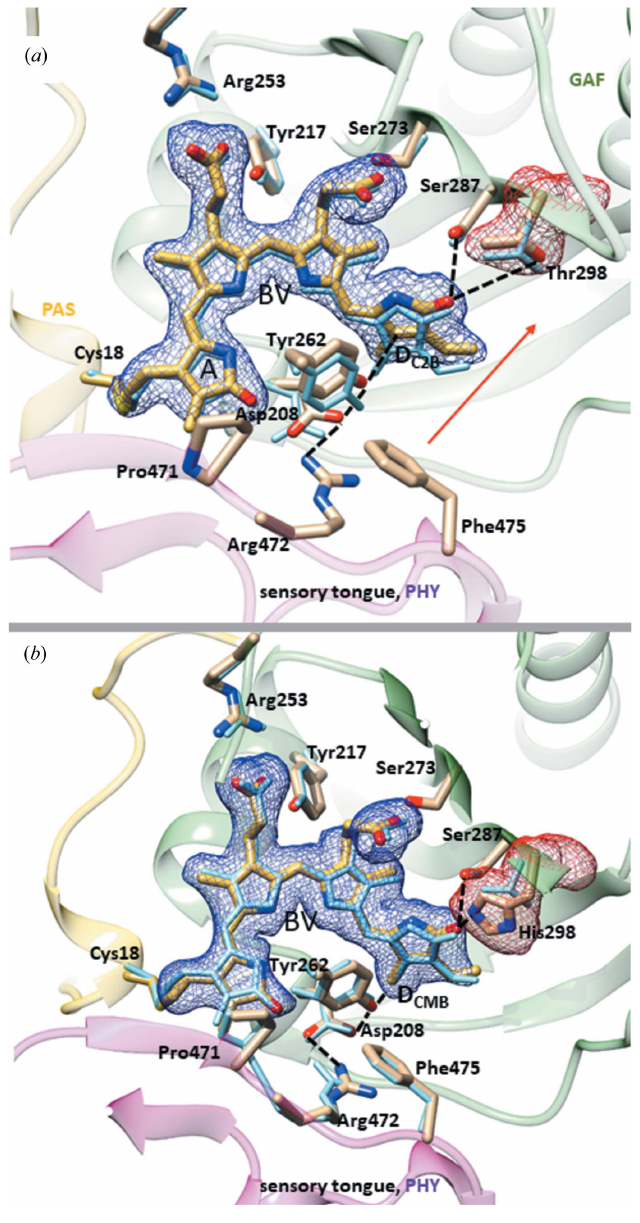
Figure 6 Structural changes in SaBphP1 near the BV chromophore. Important residues are marked. Important salt and hydrogen bonds are shown by dashed lines. ( a ) Effect of adding the PHY domain. Blue atomic structure, CBD-wt; yellow atomic structure, PCM-wt. The electron density (simulated annealing OMIT mF o (cid:5) DF c , dark blue, contour level: 2 (cid:7) ) is shown for the chromophore and the Thr289 (red). The red arrow indicates the overall trend of the changes. ( b ) Effect of the T289H mutation. Blue atomic structure: PCM-wt, yellow atomic structure: PCM- T289H. The electron density (simulated annealing mF o (cid:5) DF c , light blue, contour level: 2 (cid:7) ) is shown for the chromophore and the His289 (red).